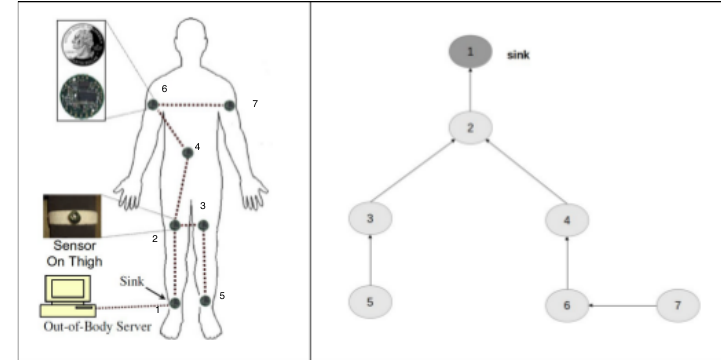
Figure 4. Quwaider wireless body sensor network (WBSN) and related